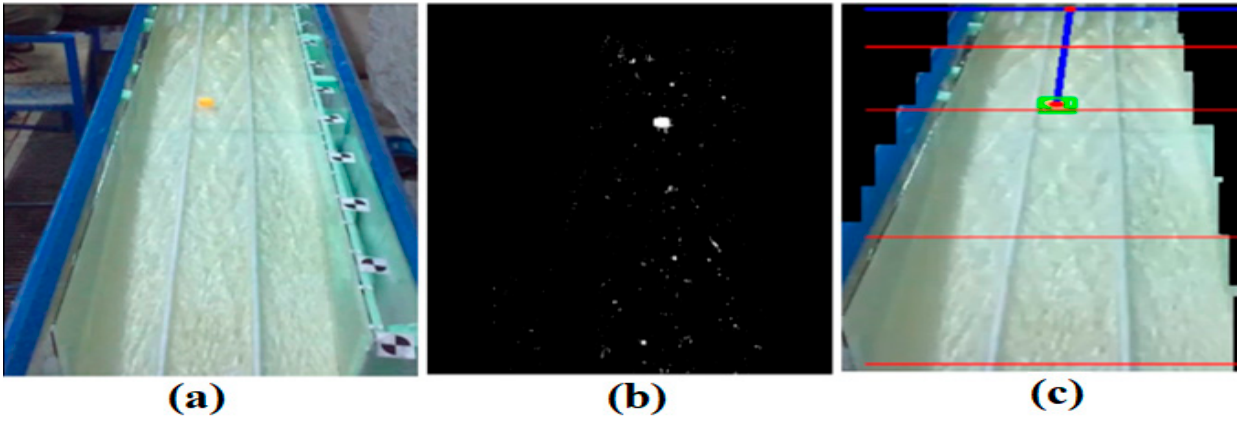
Figure 10. The OpenCV code stages: ( a ) reading current video image; ( b ) image filtering for floating object detection and tracking; ( c ) calculation of the velocity of the tracked object (Red lines indicate cross-section locations, blue lines indicate the distance of the float from the origin).